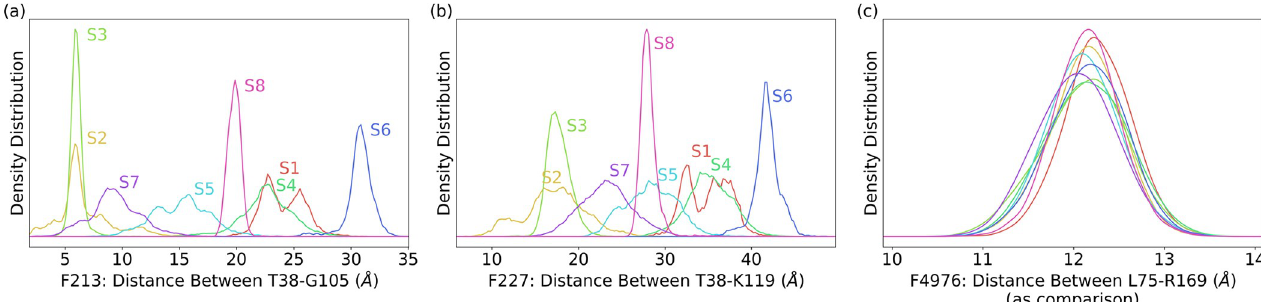
Fig 8. Distributions of selected features (pair-wised C α distances) in different states. (a) Distribution of Feature 213 as T38/G105 distance in all eight macrostates. This is the top one with overall 2.83% importance. (b) Feature 227 as T38/K119 distance in all eight macrostates. This is the second most important feature with overall 2.38% importance. (c) Feature 4976 L75-R169 with overall 0.0% importance. This unimportant feature has the similar distribution in all eight